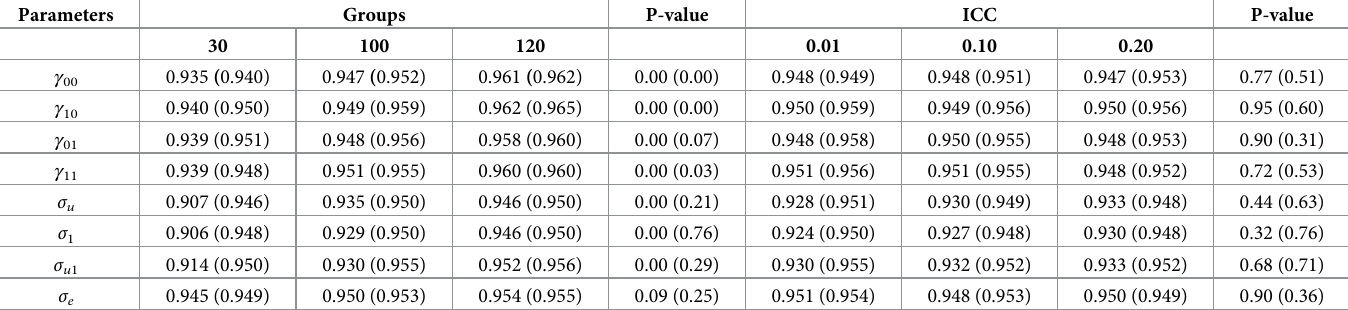
Table 3. Impact of groups and ICC on estimates 95% coverage probability for normal distribution data (First = REML estimation procedure, Second = Percentile bootstrap estimates are enclosed in Parenthesis). Parameters